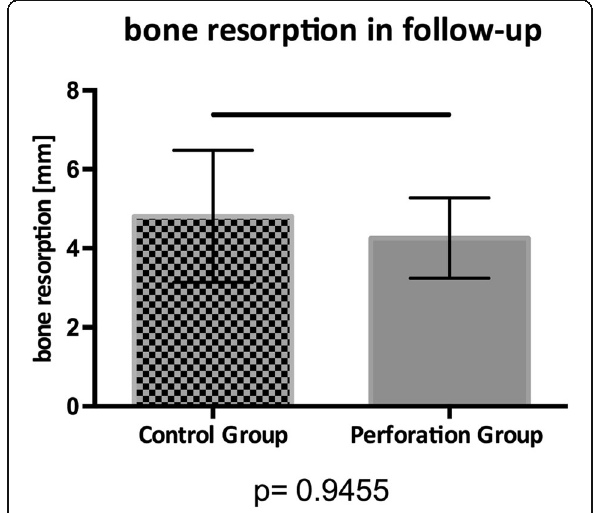
Fig. 5 Bone resorption in the follow-up of the control group and the perforation